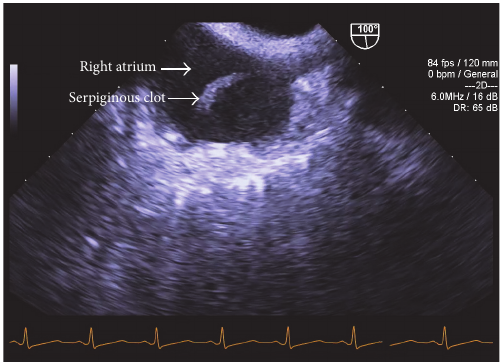
Figure 2: Preanhepatic phase. TEE midesophageal bicaval view: fibrous clot in right atrium.